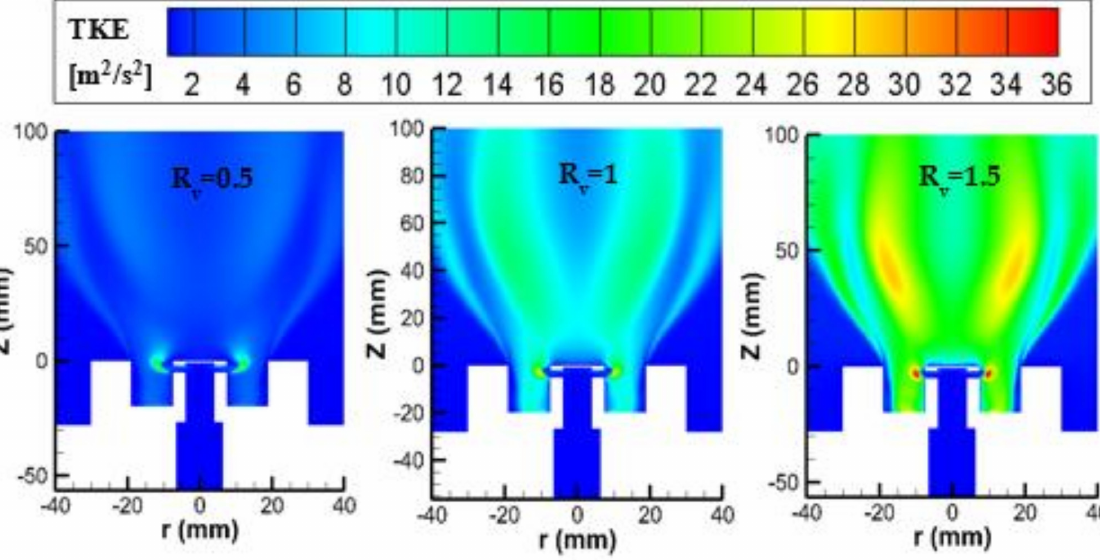
Figure 7. Contours of obtained numerical turbulent kinetic energy in the plane (X,